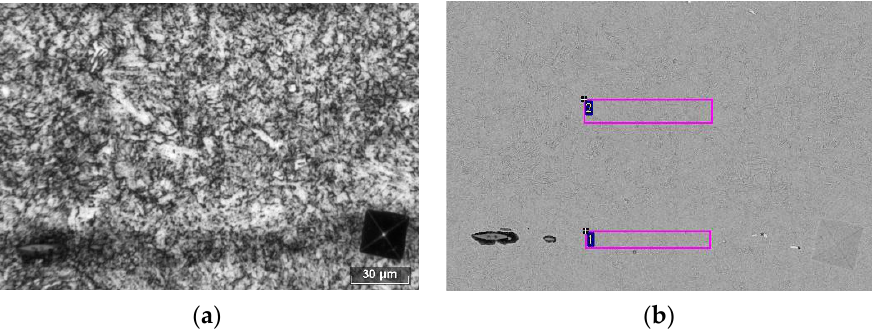
Figure 15. Comparison of LOM ( a ) and SEM ( b ) images of microstructure in segregations and base metal in CT. Also shown are areas for determining the chemical composition. Table 6. Chemical composition of the segregations and the base metal of the casing tube (CT) sample, wt. %.